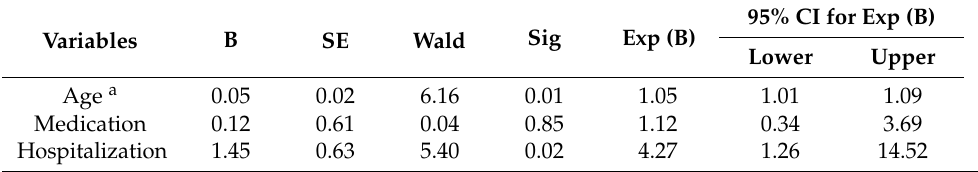
Table 3. Multiple logistic regression model with antibody test result (positive vs. negative) as a dependent variable.